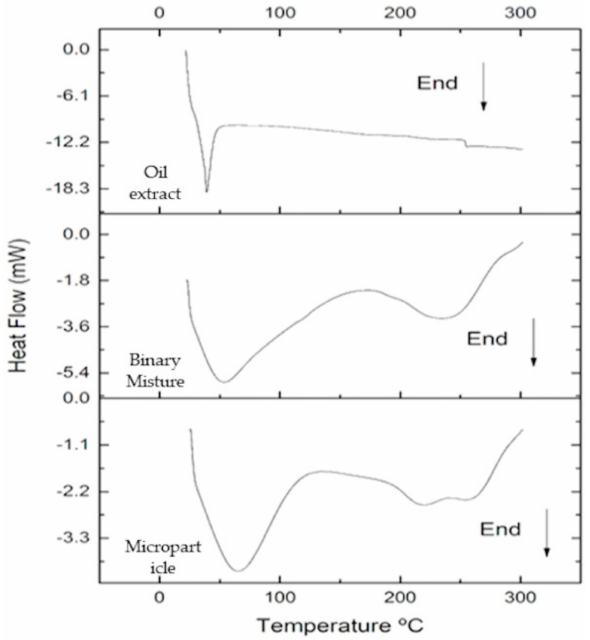
Figure 3. DSC curve of the oily extract, binary mixture of adjuvants and microparticle. Conditions: nitrogen atmosphere (N 2 ), the flow of 50 mL/min, the heating rate of 10 ◦ C/min and a temperature of 300 ◦